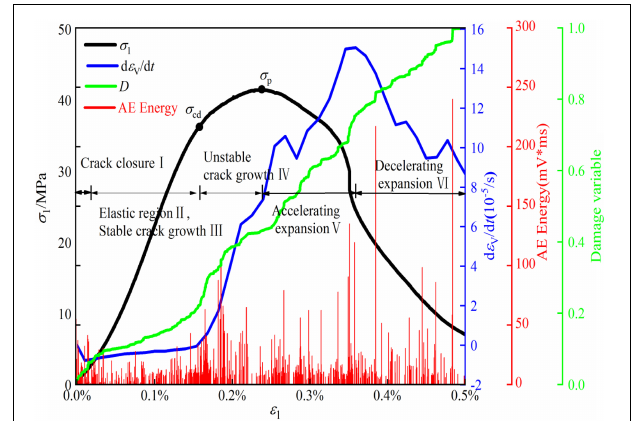
FIGURE 3 | Failure process under unaxial compression.